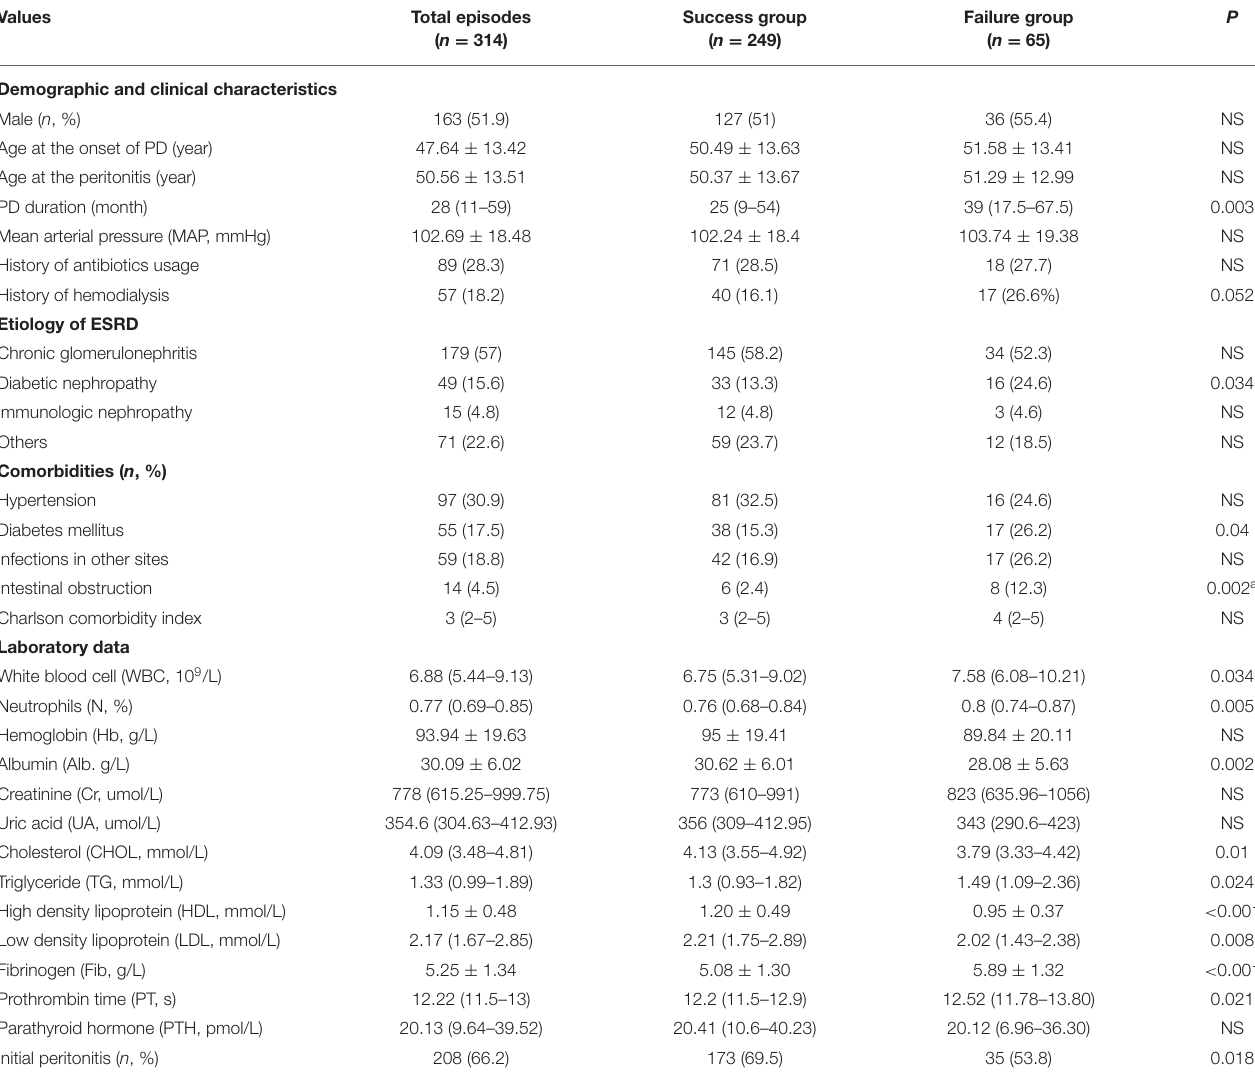
TABLE 1 | The Basic demographic and clinical characteristics, laboratory data by treatment outcomes. Values Total episodes ( n =